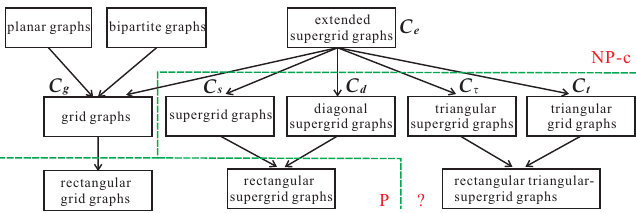
Figure 2. The containment relations among the classes of extended supergrid, grid, supergrid, diagonal supergrid, triangular supergrid, and triangular grid graphs, where C → C (cid:48) indicates that C (cid:48) is a subclass of C . NP-c = NP-complete, P = Polynomial, and ? = unknown for the studied problems. A rectangular grid graph, denoted G m × n , is the Cartesian product of paths P m and P n ; thus, ( u , v ) ∈ E ( G m × n ) if and only if their distance is 1, that is, | u x − v x | + | u y − v y | = 1, where P i is the simple path with i vertices. A rectangular supergrid (called King’s ) graph, denoted R m × n , is the strong product of paths P m and P n ; thus, ( u , v ) ∈ E ( R m × n ) if and